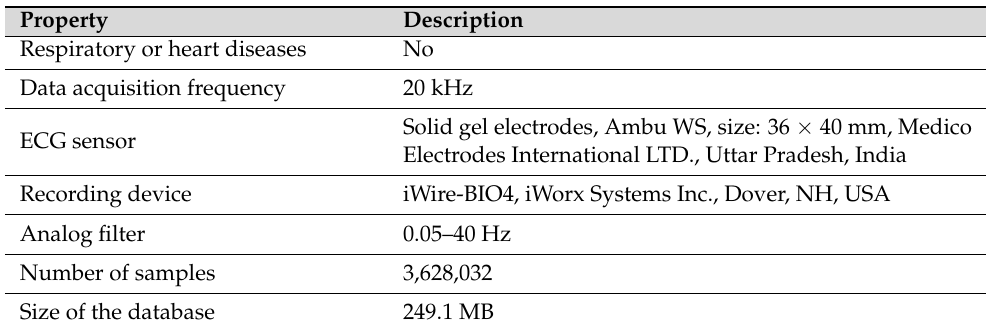
Table 1. Important properties of the data acquisition procedure.